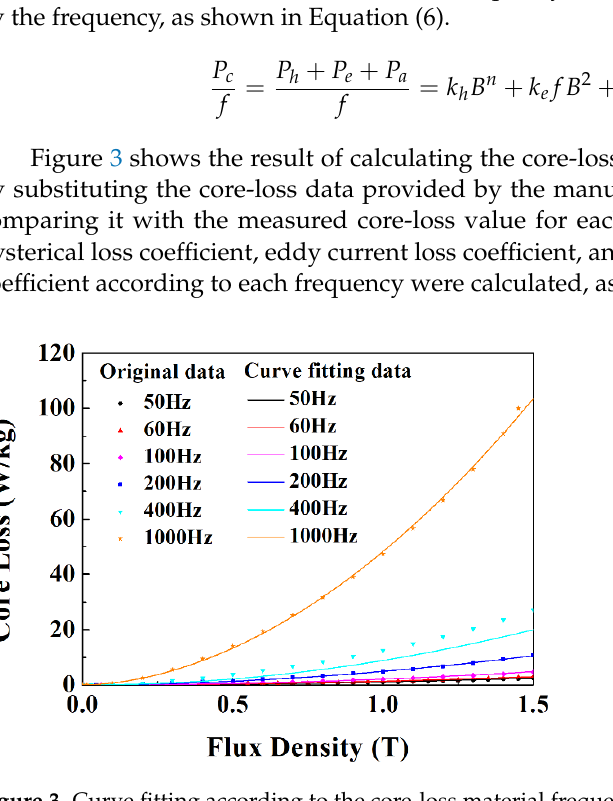
Figure 3. Curve fitting according to the core-loss material frequency. Table 2. Core-loss coefficient according to